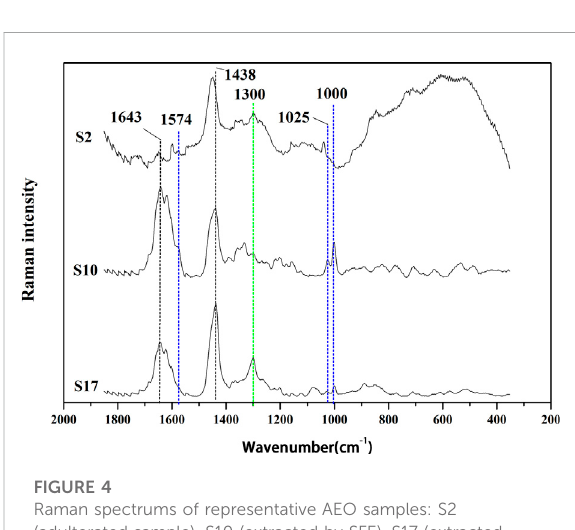
FIGURE 4 Raman spectrums of representative AEO samples: S2 (adulterated sample), S10 (extracted by SFE), S17 (extracted by